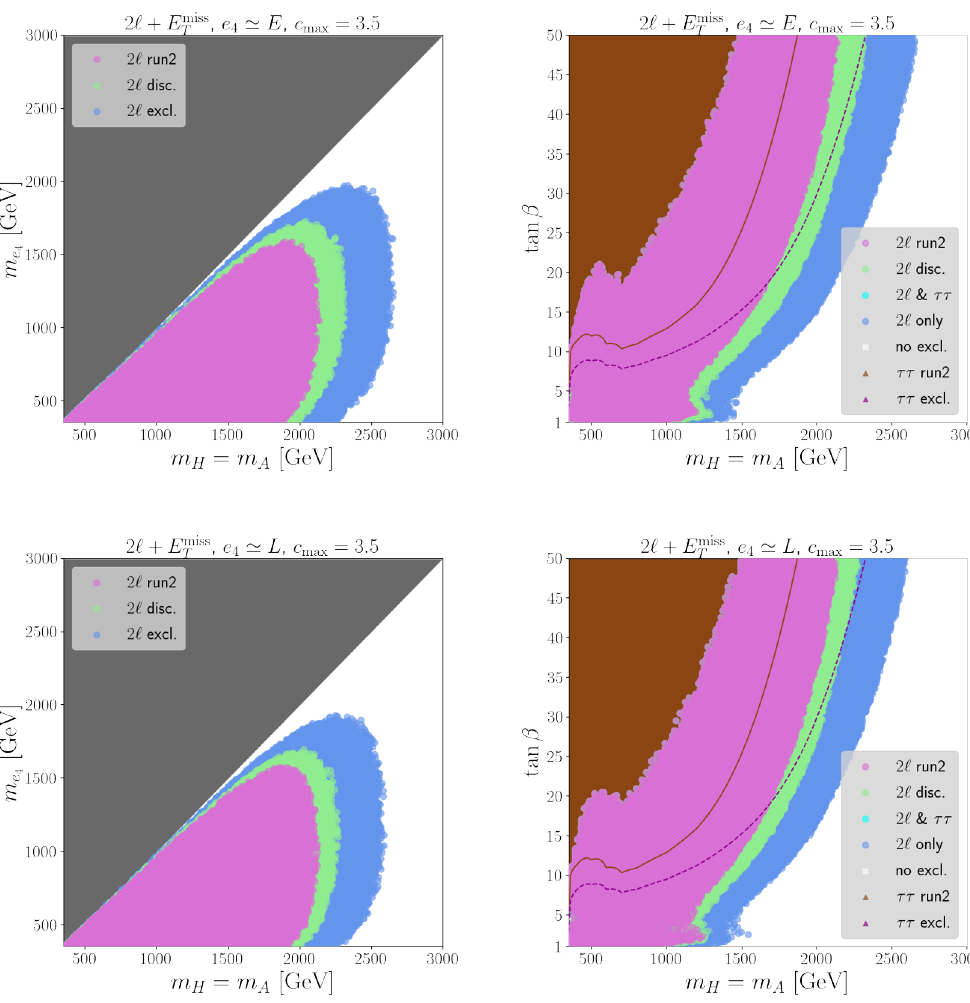
Figure 14 . Sensitivities of the 2 ‘ + E miss search to the light-E (light-L) scenario with c max = 3 . 5 T in the upper (lower) panels. The labels are the same as those in figure